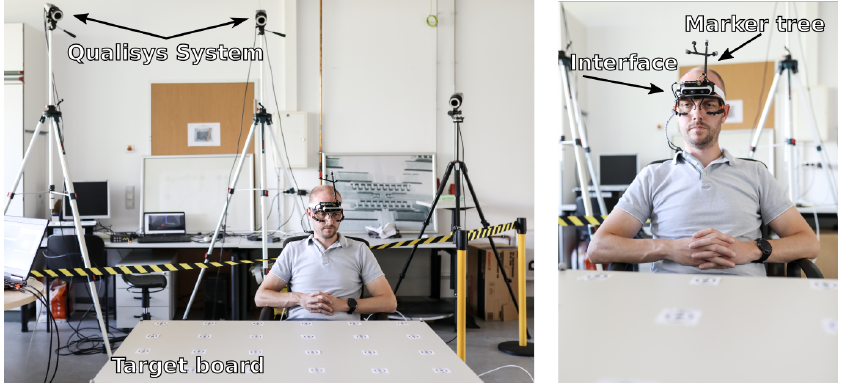
Figure 8. Experimental Setup. The user is wearing the interface and is sitting at a table in front of a Qualisys motion capture system. The user points at targets by either head-gaze or eye-gaze. The interface is equipped with a rigid marker tree that is attached on top of the custom camera case to capture ground truth